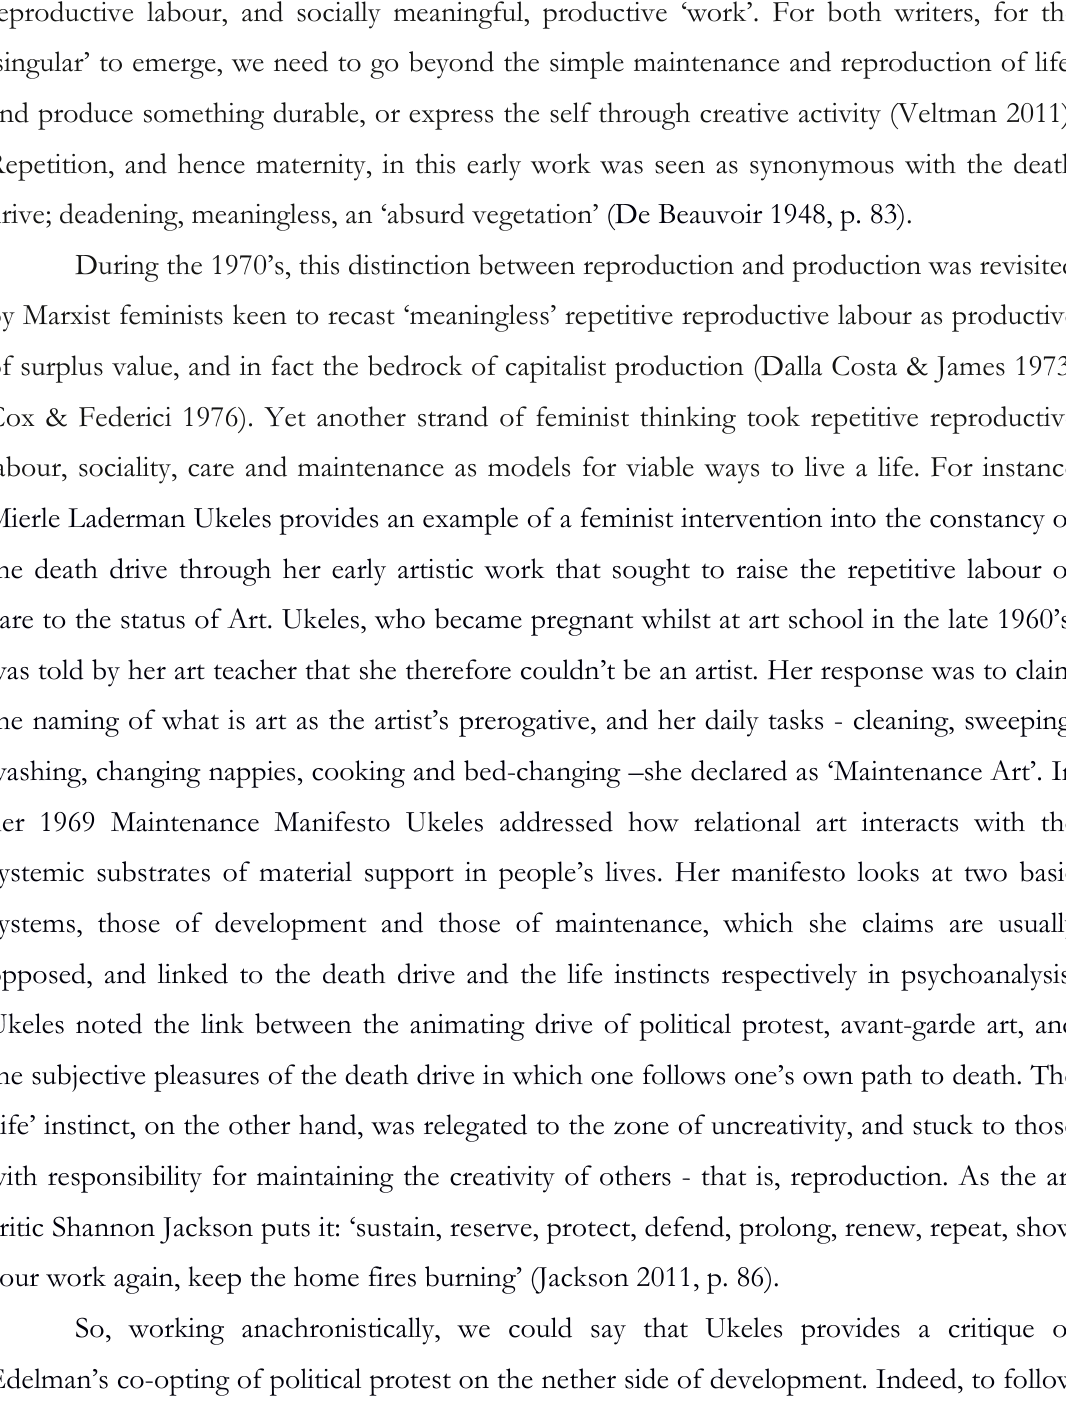
Lisa Baraitser, Time and Again: Repetition, Maternity and the Non-Reproductive Studies in the Maternal , 6(1), 2014,